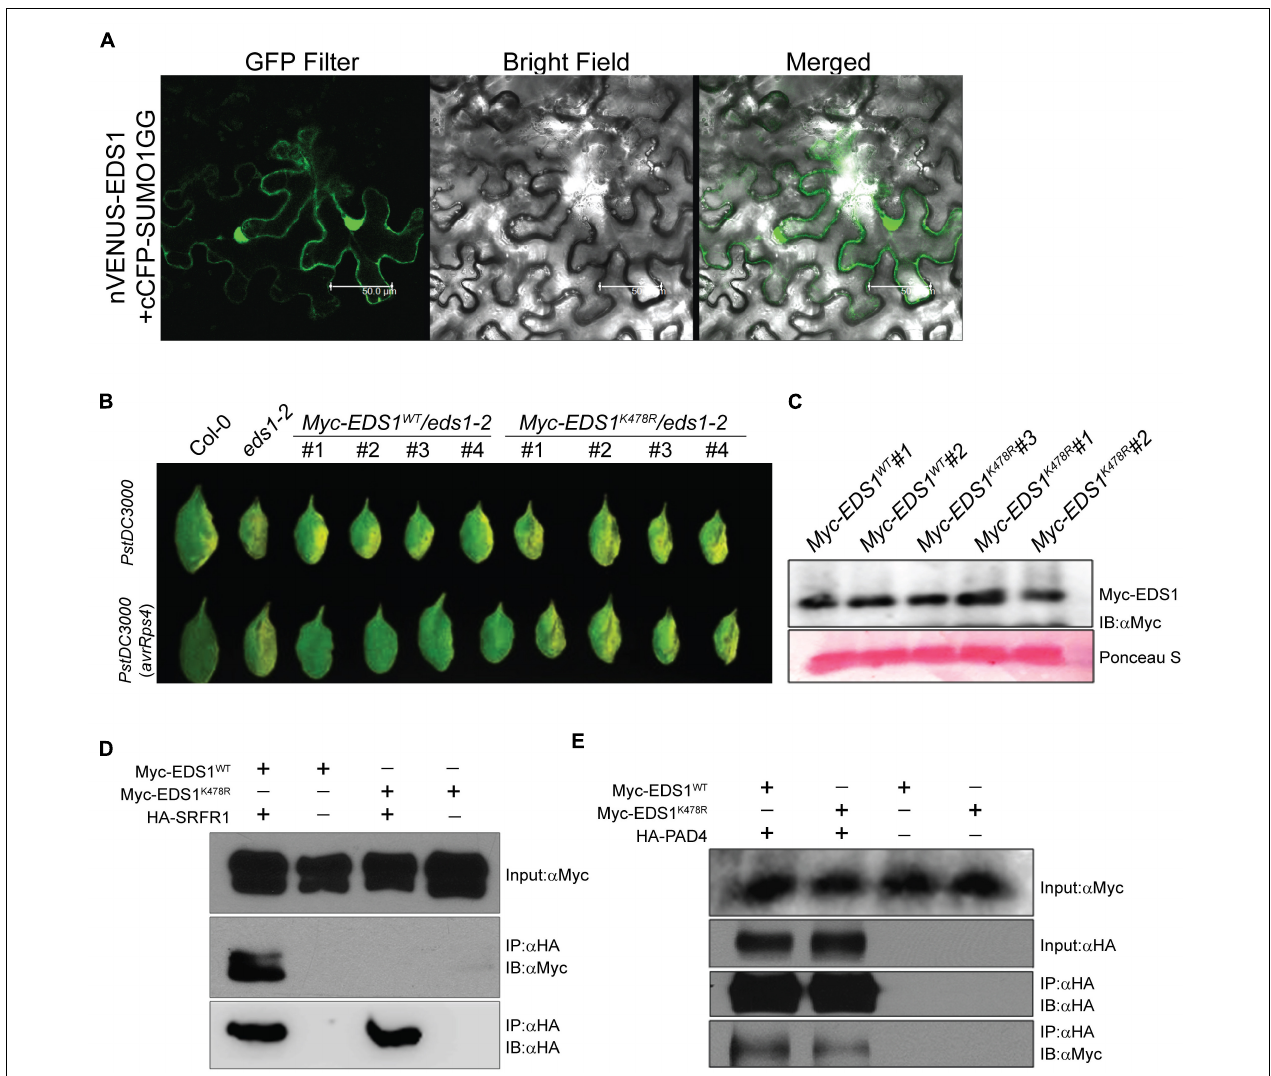
FIGURE 4 | EDS1 K478R does not interact with SRFR1 and is functionally deficient in supporting defenses. (A) EDS1 interaction with SUMO1 in bimolecular fluorescence complementation (BiFC) assays. YFP reconstitution was detected with a confocal microscope equipped with a GFP filter. Also shown are merge of GFP filter and bright-field images. Scale bar = 50 µ m. (B) Disease symptoms on independent transgenic plants expressing Myc-EDS1 WT or Myc-EDS1 K478R in eds1-2 background infected with virulent PstDC3000 ( top panel ) or avirulent PstDC300 ( avrRps4 ) ( bottom panel ) strains. (C) Expression levels of Myc-EDS1 WT and Myc-EDS1 K478R in independent transgenic lines. Total protein extracts were immunoblotted with anti-Myc antibodies. (D) Immuno-enrichment of HA-SRFR1 co-elutes Myc-EDS1 WT but not Myc-EDS1 K478R . Co-expression was performed in Nicotiana benthamiana leaves, and anti-HA immuno-enrichments were probed with anti-HA or anti-Myc antibodies, as indicated. (E) Both Myc-EDS1 WT and Myc-EDS1 K478R interact similarly with HA-PAD4. PAD4 was pulled down with anti-HA antibodies and probed for Myc-EDS1 or Myc-EDS1 K478R